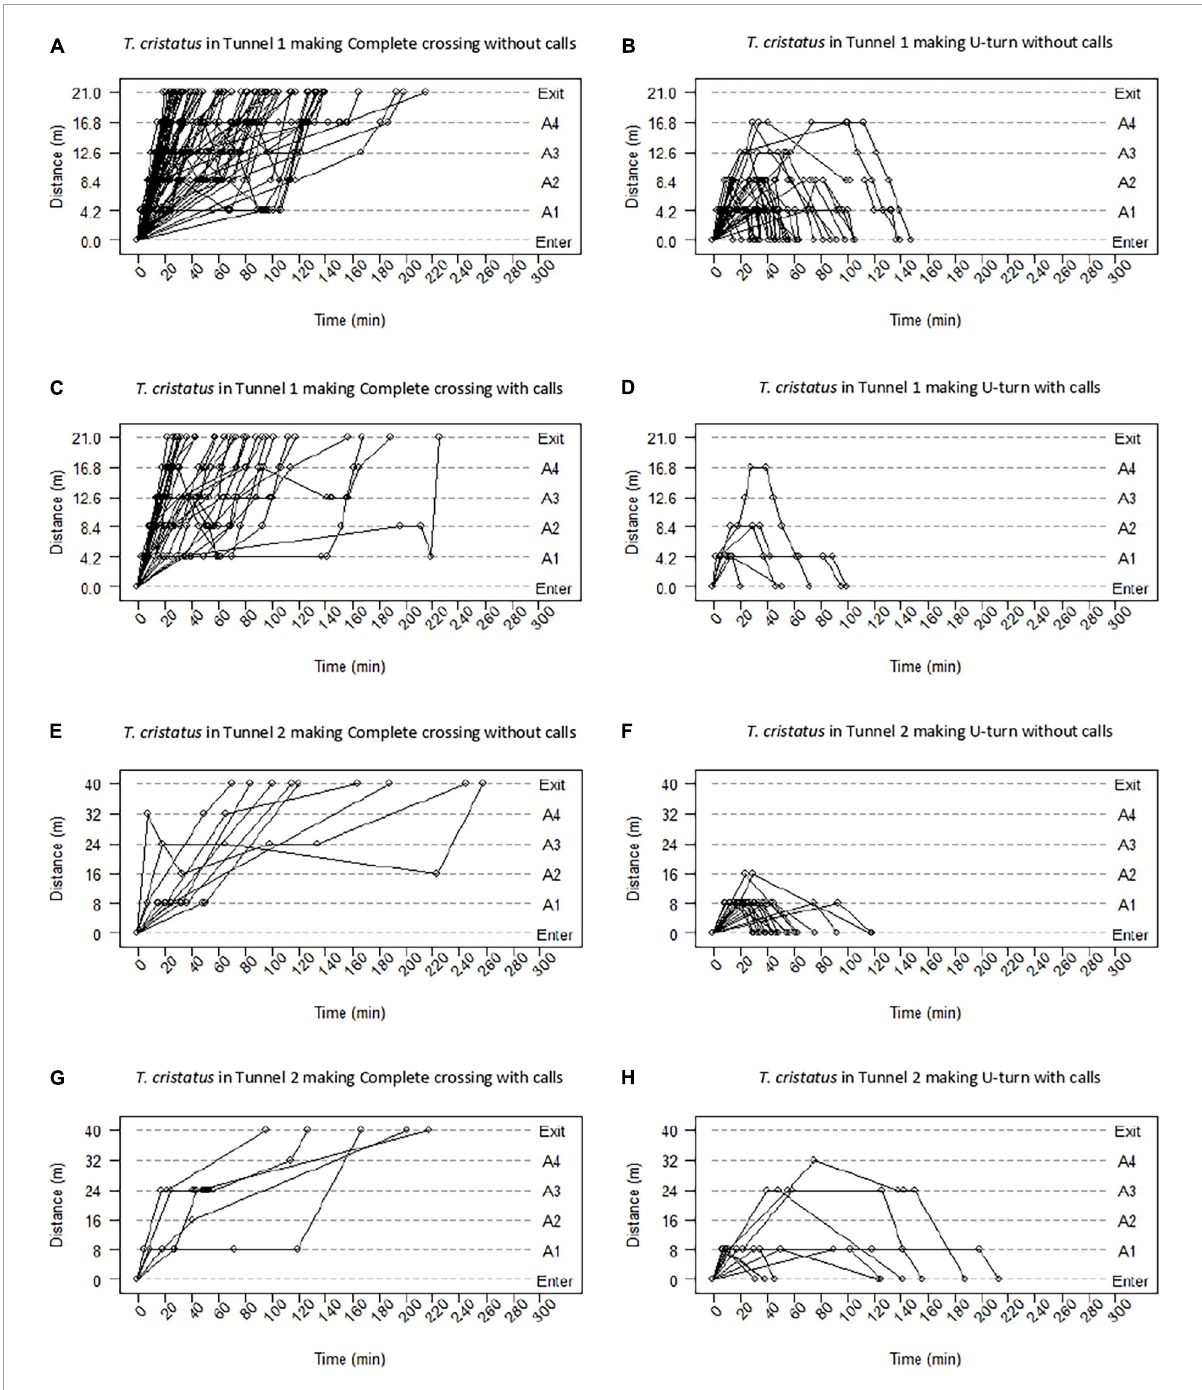
FIGURE4 Trajectories of T. cristatus in Tunnels 1 and 2 without acoustic enrichment (T1) and with acoustic enrichment (T2) to complete crossing (left) and U-turn (right). The dashed lines represent the entry, exit, and location of the antennas in the tunnels. The positions of the individuals in the tunnels at the time since release are represented by dots. The solid lines represent the speed of movement between the different positions. Panel (A) represents trajectories of newts making a complete crossing in Tunnel 1 without enrichment. Panel (B) represents trajectories of newts making a U-turn in Tunnel 1 without enrichment. Panel (C) represents trajectories of newts making a complete crossing in Tunnel 1 with enrichment. Panel (D) represents trajectories of newts making a U-turn in Tunnel 1 with enrichment. Panel (E) represents trajectories of newts making a complete crossing in Tunnel 2 without enrichment. Panel (F) represents trajectories of newts making a U-turn in Tunnel 2 without enrichment. Panel (G) represents trajectories of newts making a complete crossing in Tunnel 2 with enrichment. Panel (H) represents trajectories of newts making a U-turn in Tunnel 2 with